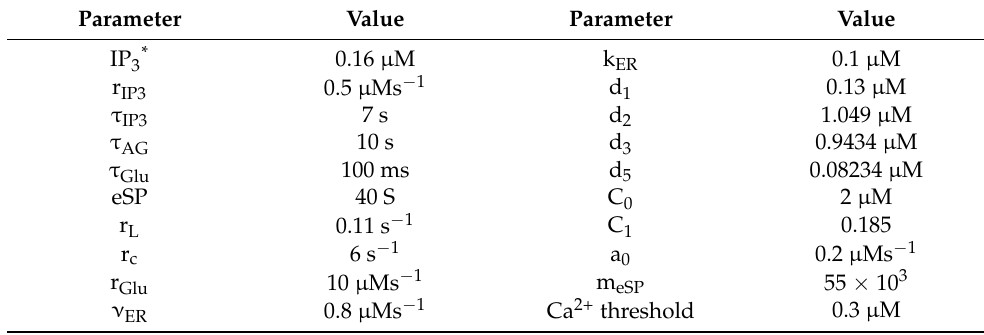
Table A2. Parameter values for the astrocyte–neuron model.